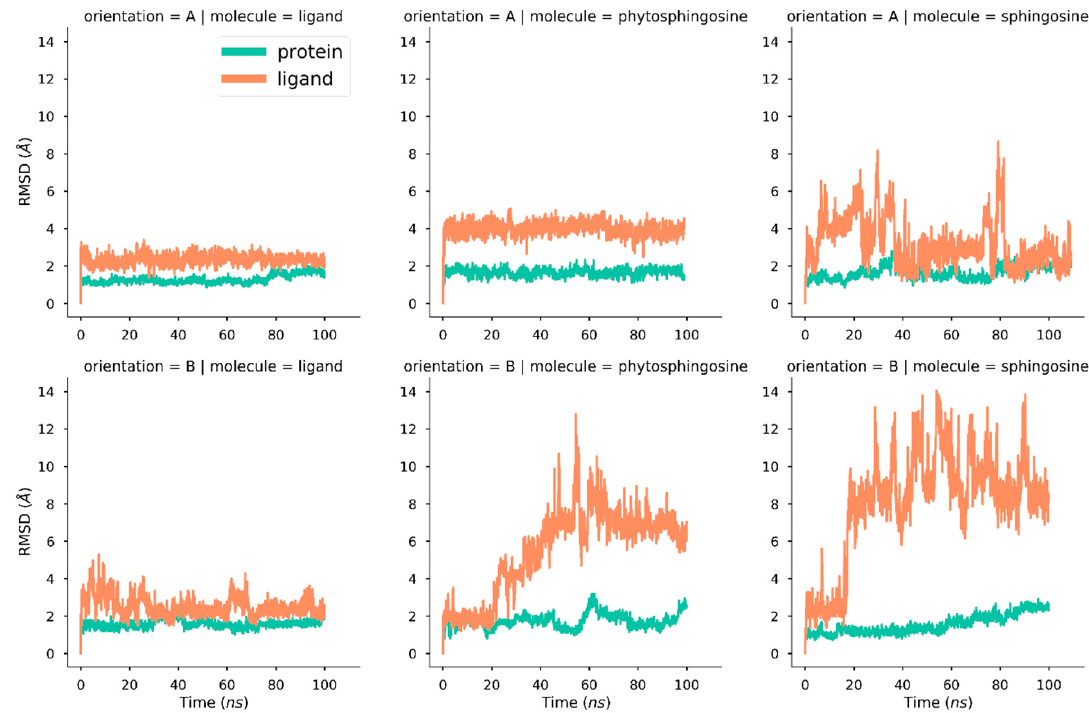
Figure 2. RMSD of protein (backbone atoms) and ligands along 100 ns trajectories for the orientations A and B inside the cavity of Pru p 3 of the three ligands studied: the phytosphingosine tail of the natural ligand of Pru p 3 (“ligand” label), phytosphingosine, and sphingosine.